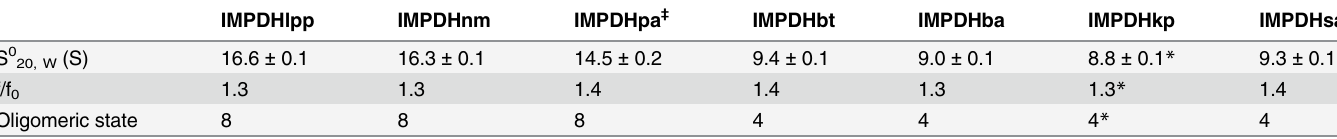
For each IMPDH, runs at four different concentrations (from 9.15 to 54.9 μ M for IMPDHba, from 1.85 to 76.8 μ M for IMPDHbt, 1.84 to 55.2 μ M for IMPDHkp, 1.83 to 54.8 μ M for IMPDHlpp, 1.84 to 55.1 μ M for IMPDHnm, 1.80 to 120 μ M for IMPDHpa and 1.82 to 54.5 μ M for IMPDHsa) were performed and absorbance at 280 nm was measured. Hydrodynamics characteristics were extrapolated to zero concentration. Sedimentation coef fi cients were expressed in Svedberg unit (1S = 10 -13 s -1 ) at 20°C in water. The frictional ratio f/f 0 is characteristic of the elongation and hydration when compared to an anhydrous sphere. ‡ Values taken from Labesse et al . [16].